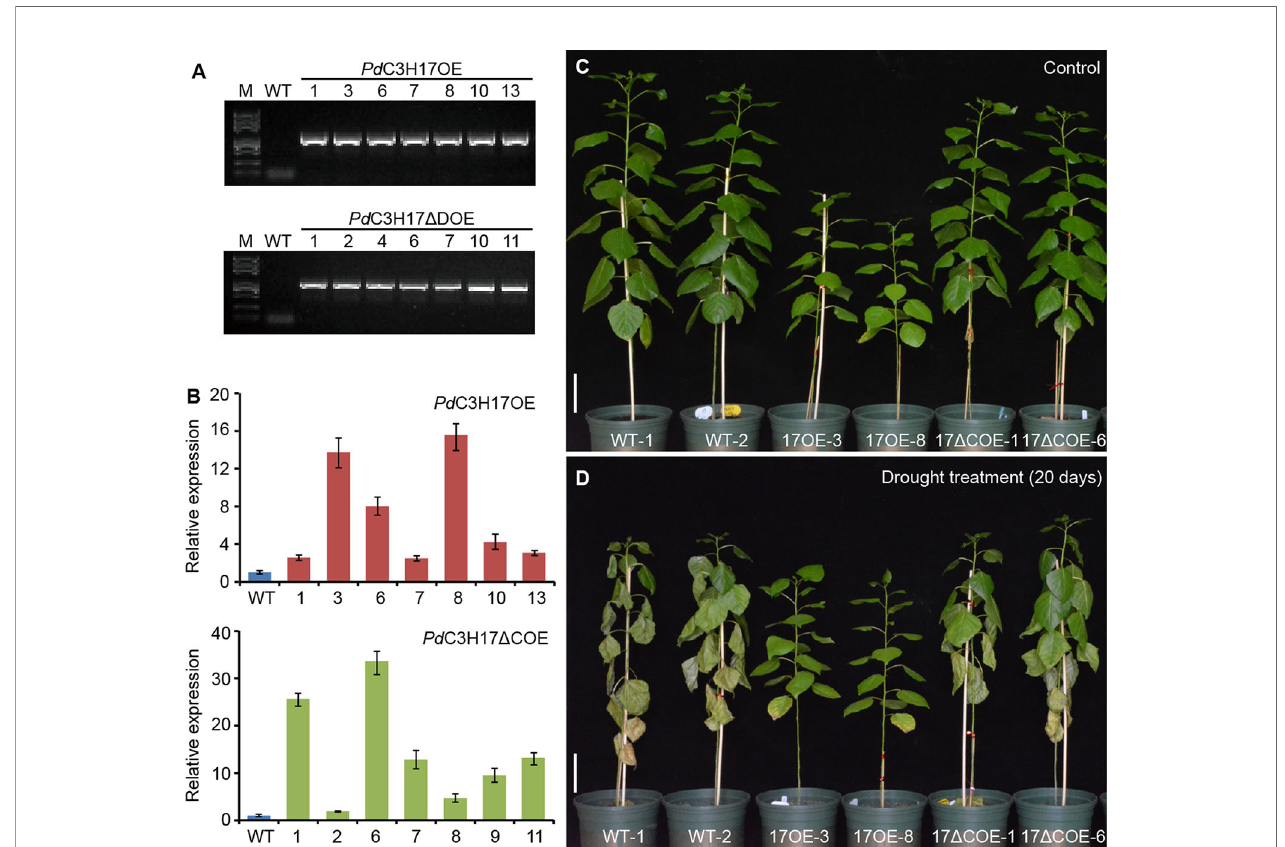
FIGURE 2 | Morphological differences between wild-type and transgenic poplars overexpressing PdC3H17 or PdC3H17 D C after well-watered or drought stress conditions for 20 days. (A) PCR identi fi cation of representative PdC3H17 and PdC3H17 D C overexpression poplar lines using pro35S and gene-speci fi c primers. Wild-type (WT) plants were used as the control. (B) qRT-PCR analysis of PdC3H17 expression in WT, Pd C3H17OE, or Pd C3H17 D COE poplar lines. (C, D) Drought response of 3-month-old representative WT, Pd C3H17OE (17OE), and Pd C3H17 D COE (17 D COE) poplar lines at the 20th day of well-watered (C) or drought (D) treatment. Bars = 10